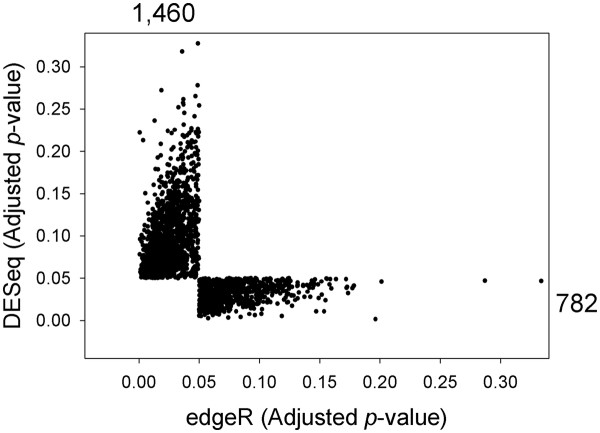
p-value comparison between edgeR and DESeq. The edgeR and DESeq p-values of the 2,242 marginally significant genes eliminated in Step C of Figure 
1 are compared.